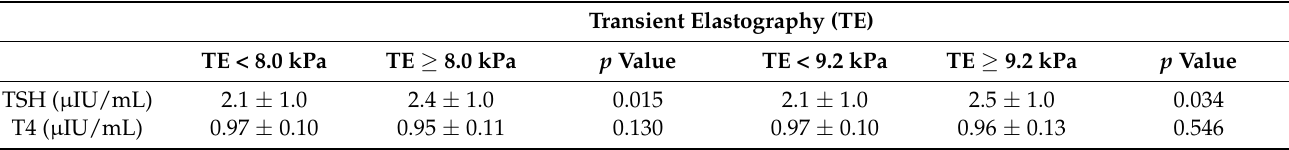
Table 3. Association between thyroid hormones and liver fibrosis using transient elastography.